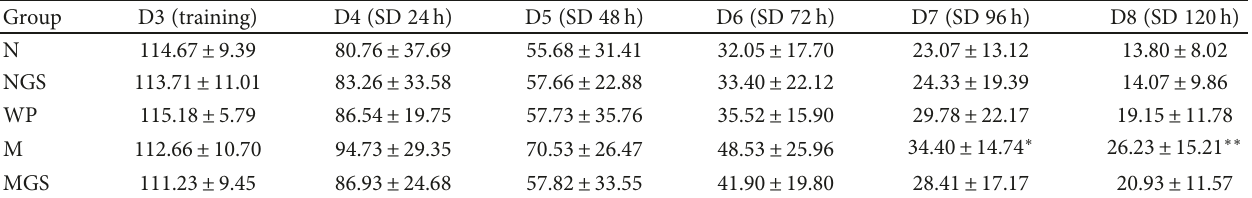
Table 1: Latent period of rats fi nding hidden platform in Morris water maze experiment (in